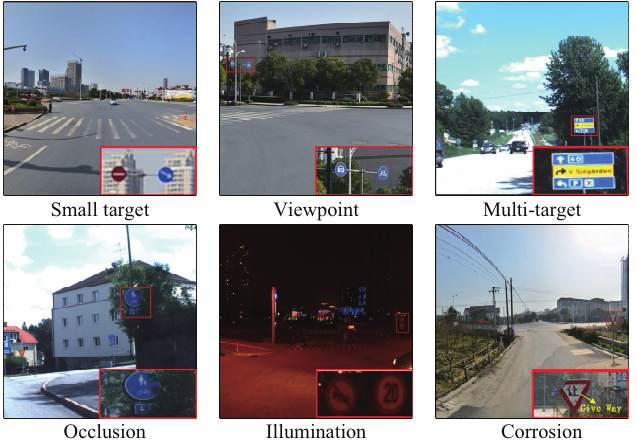
Figure 1. Examples of common factors affecting traffic sign detection capabilities sampled from the original